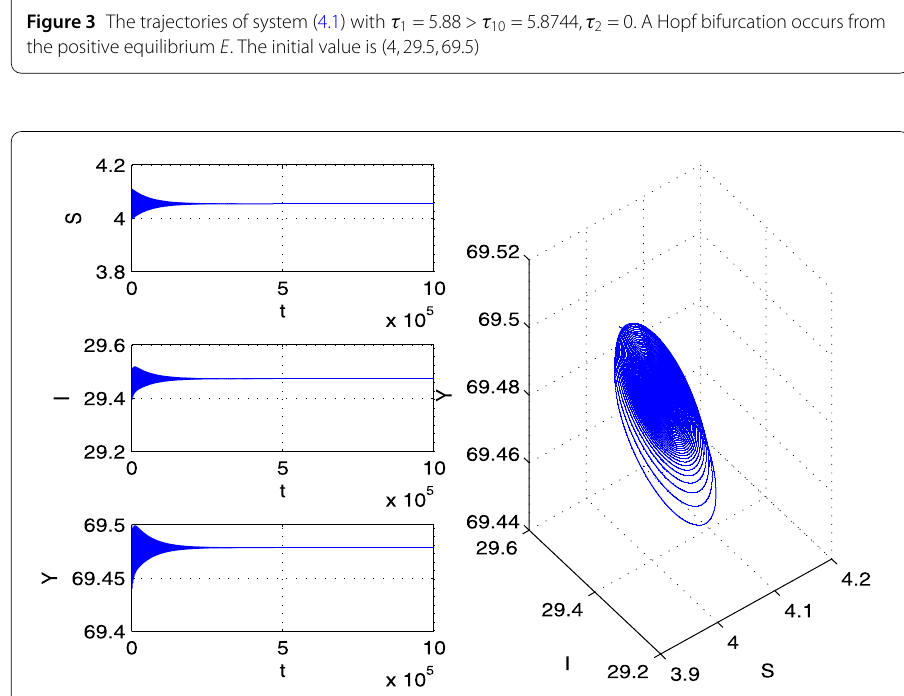
Figure 4 The trajectories of system (4.1) with τ 1 = 5.79, τ 2 = 1 < τ ∗ 20 = 4.5647. The positive equilibrium E is asymptotically stable. The initial value is (4,29.5,69.5)